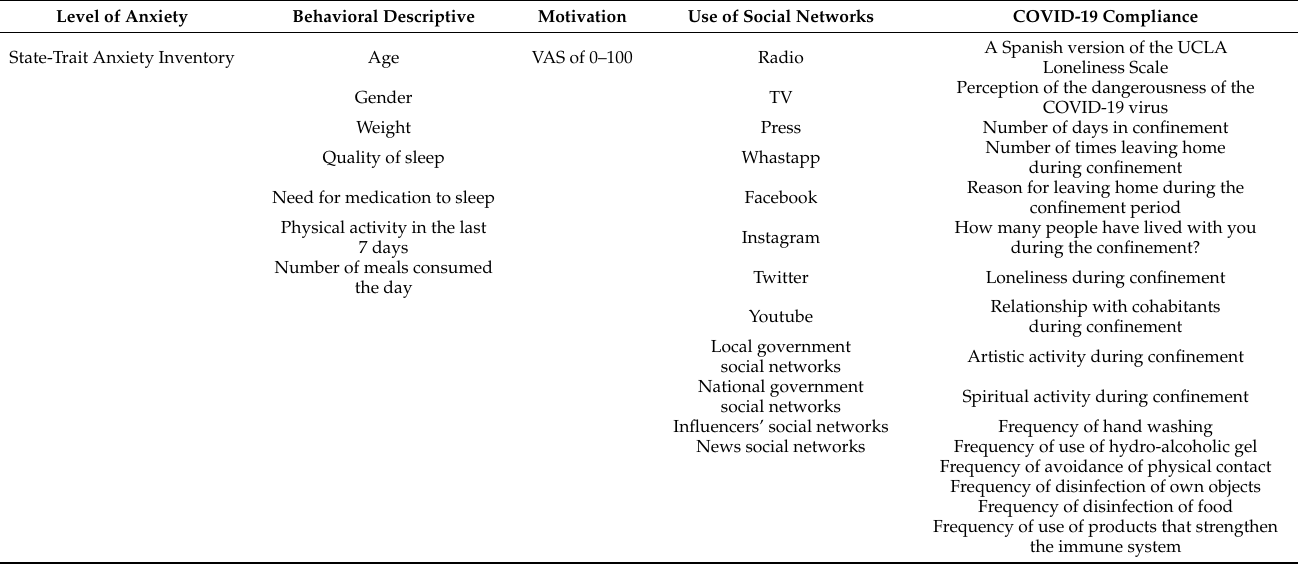
Table 1. Summary of measures analyzed.